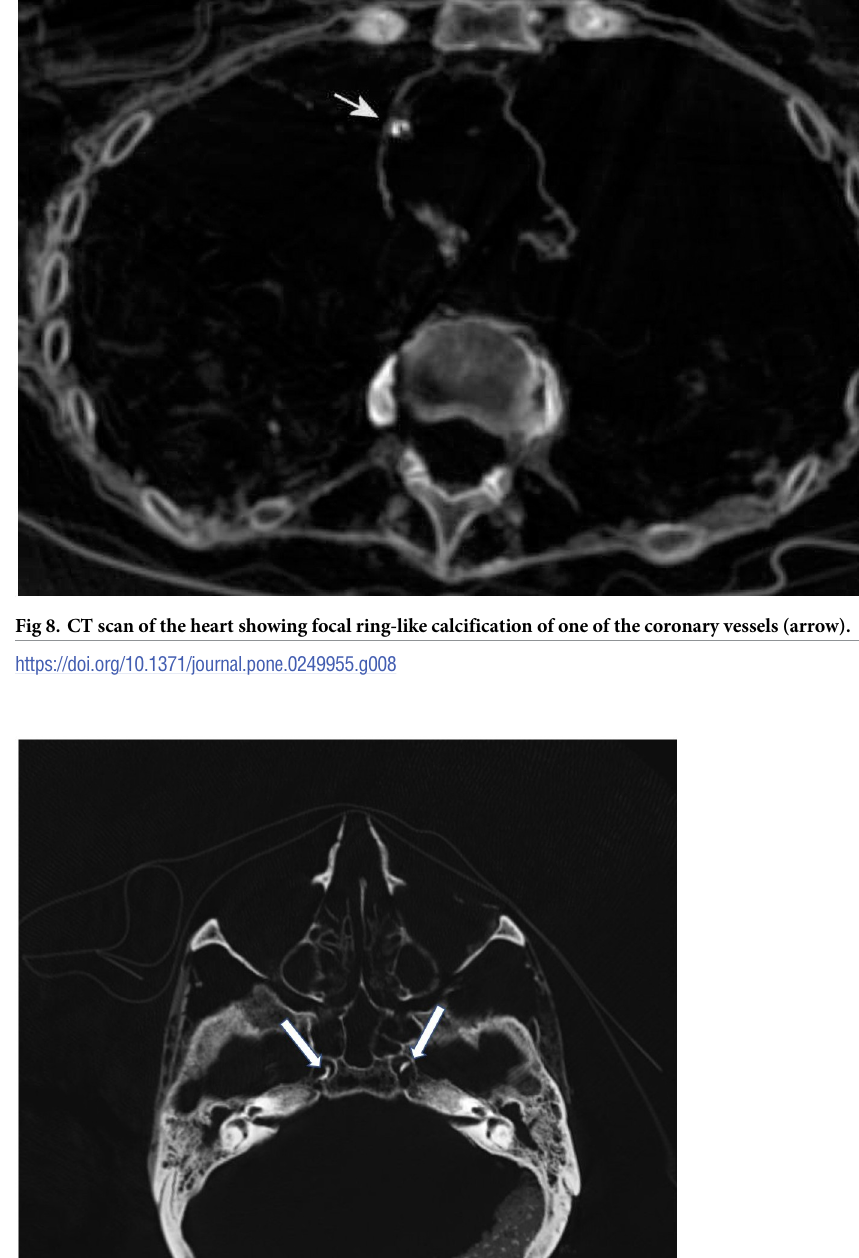
PLOS ONE | https://doi.org/10.1371/journal.pone.0249955 May 4,